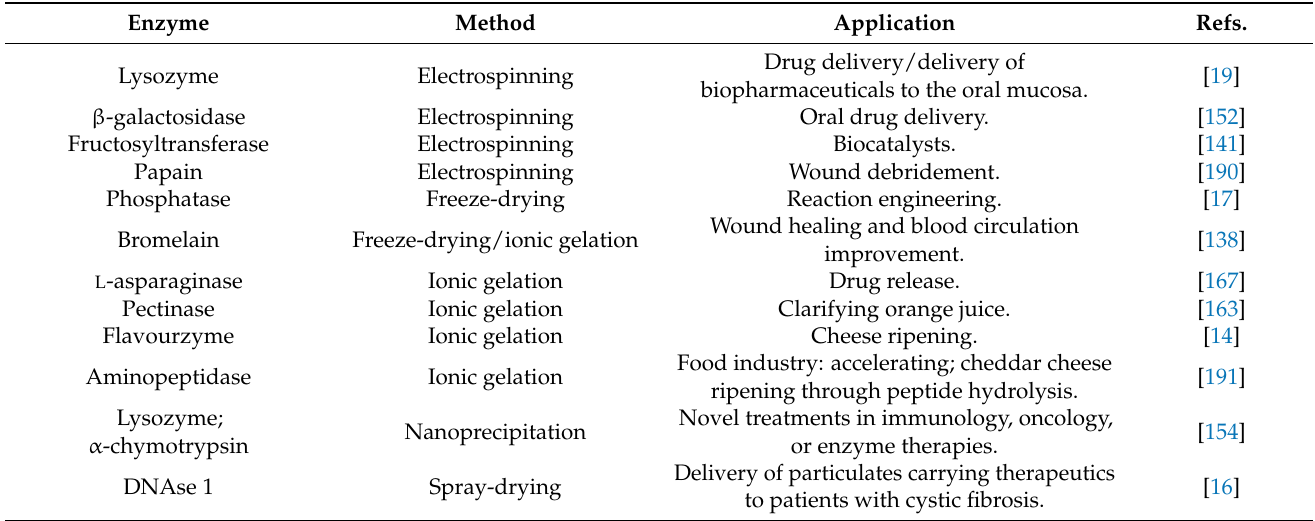
Table 2. Application of polymer encapsulated